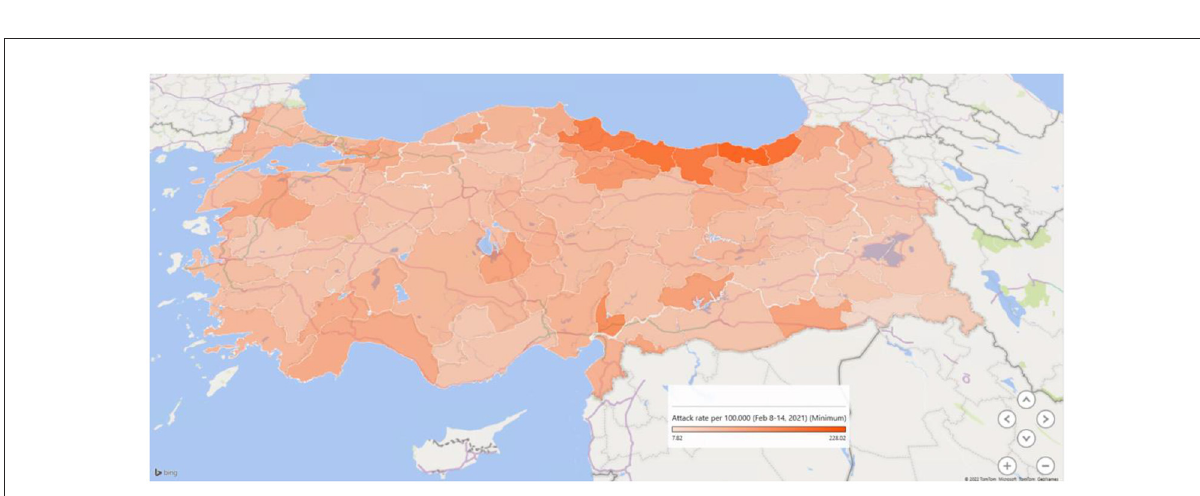
FIGURE3 The attack rate of COVID-19 (per 1,00,000 population) on February 8–14, 2021, in the provinces of Turkey.